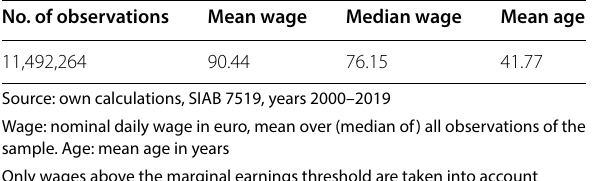
Table 5 Summary statistics SIAB-Pure 1 sample